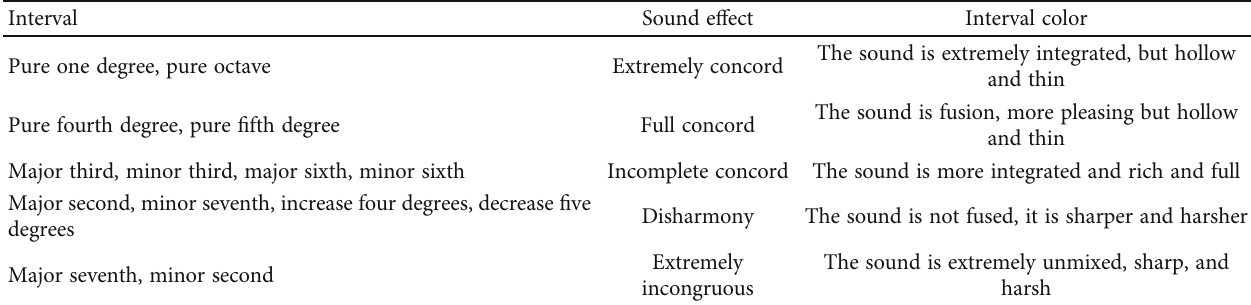
Table 1: Sound e ff ects and interval colors of various intervals.